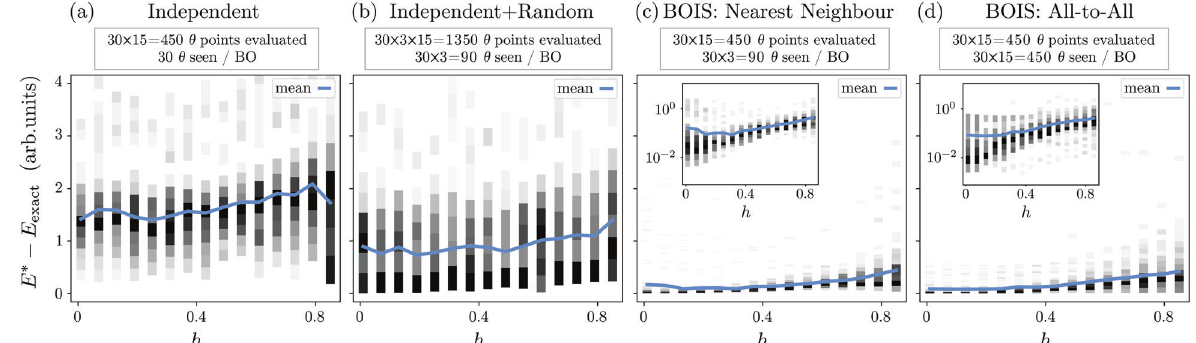
Fig. 2 Numerical study of the effectiveness of information sharing. Comparison between ( a – b ) independent vs ( c – d ) information shared VQE optimisation strategies for the quantum spin model, Eq. (2) with fi eld h = h X = h Z . The sample distribution of 100 repetitions of the same optimisation are shown as density plots for each h α , with darker shades corresponding to more observations, and the solid curve showing the mean. Optimisation is run for thirty iterations and we consider fi fteen values of h α . Data boxes show the total number of function evaluations per repetition and the number of evaluations seen by each optimiser Bð h α Þ , in addition to the numbers quoted each BO receives ten initialisation data points that are also either independent or shared (see “ Practicals aspects of Bayesian optimisation ” in the “ Methods ” section). a Independent BO ’ s at each h α . b As before, but each optimiser requests two additional energy evaluations (at random θ parameter points) at each iteration. c BOIS nearest-neighbour information sharing, i.e. BO ’ s at neighbouring h - fi eld points (e.g. h α and h α ±1 ) share device measurement results. d BOIS all-to-all information sharing, i.e., every BO sees all device measurement results. Insets of ( c ) and ( d ) show the same data on a